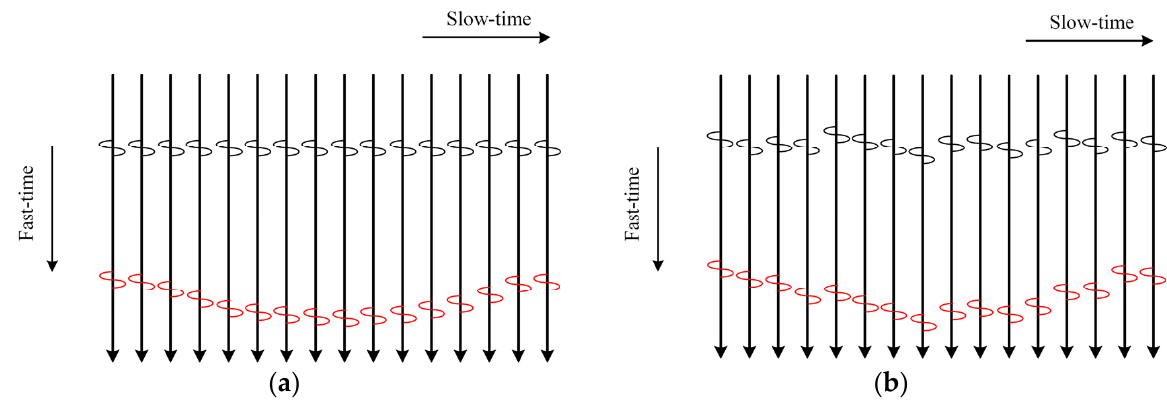
Figure 1. Under the condition that there is only one human target and one stationary target in the detection area, impulse responses recorded by the ultra-wideband (UWB) radar: ( a ) without timing jitter, and ( b ) with timing jitter.